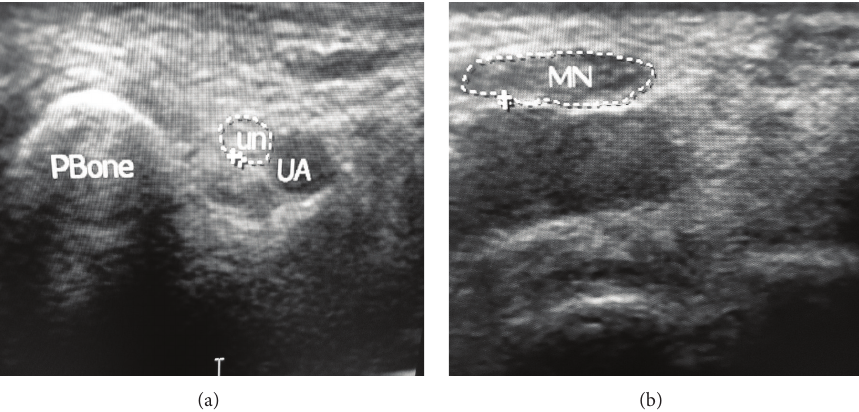
Figure 1: Wrist ultrasound at the carpal tunnel inlet for patient with mild CTS: (a) medial and (b) lateral aspects of the wrist (the tracing method for measuring the cross sectional area of the median nerve which was 10mm 2 ). UA: ulnar artery, UN: ulnar nerve in the Guyon canal, Pbone: pisiform bone, MN: median